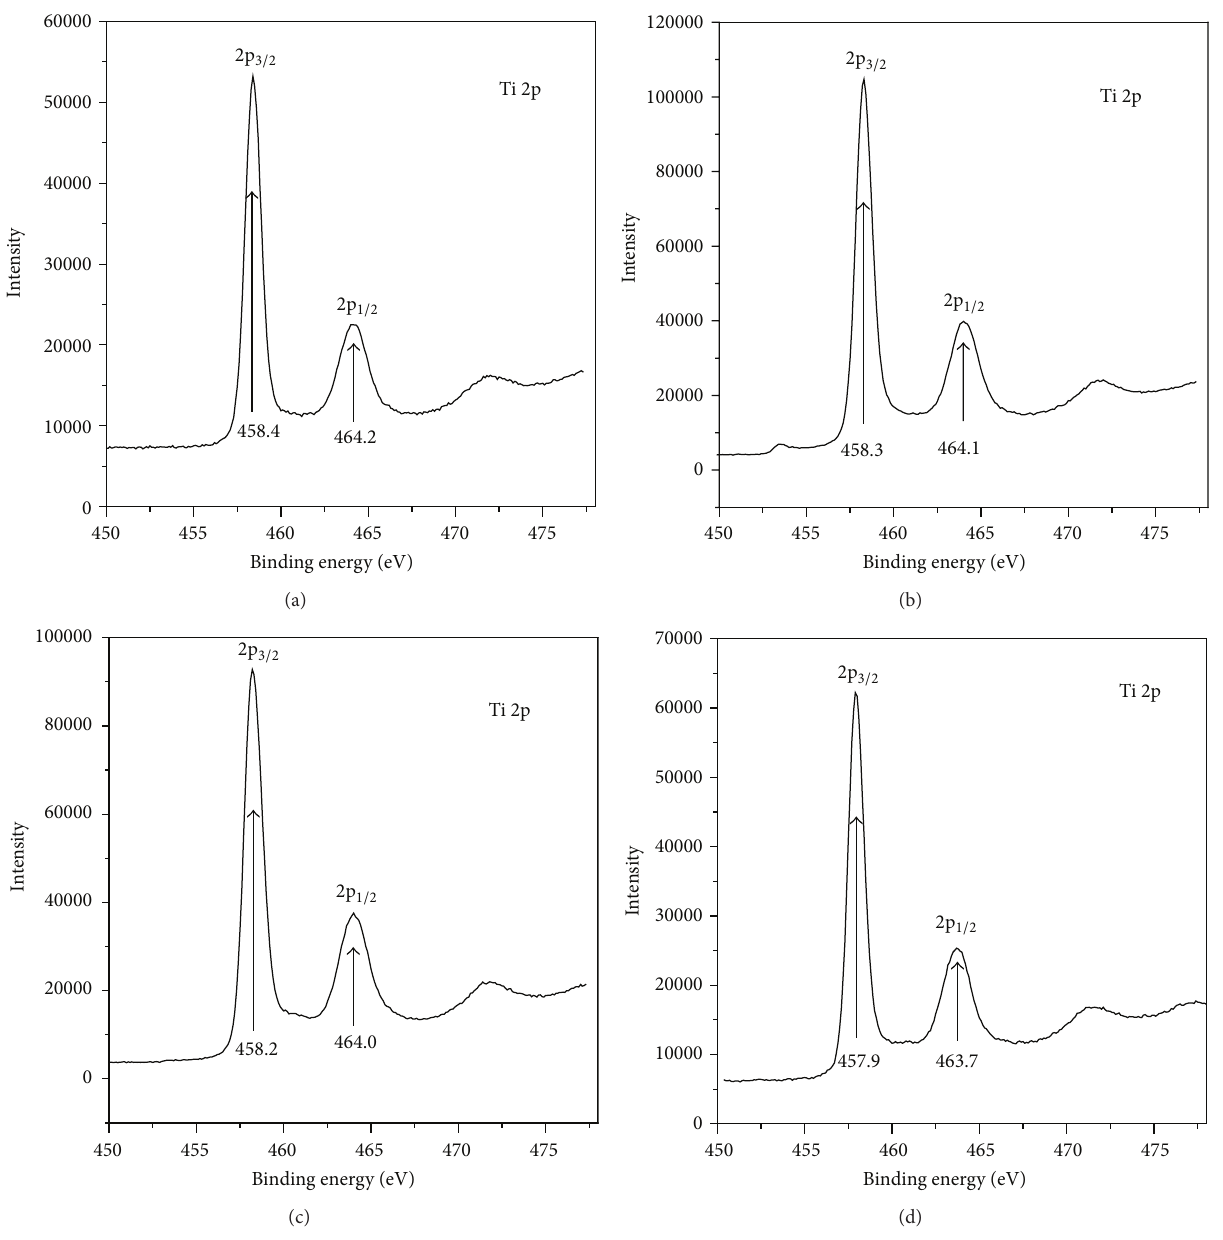
Figure 4: XPS spectrum of Ti 2p in the TiO 2 formed by Ti implanted into Ti foil and subsequent annealing at 400 (a), 500 (b), 600 (c), and 700 ∘ C (d) for 6 hours in oxygen atmosphere,